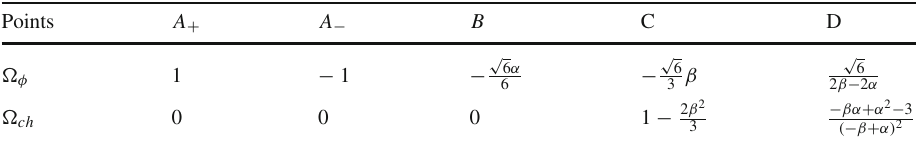
Table 2 Critical points